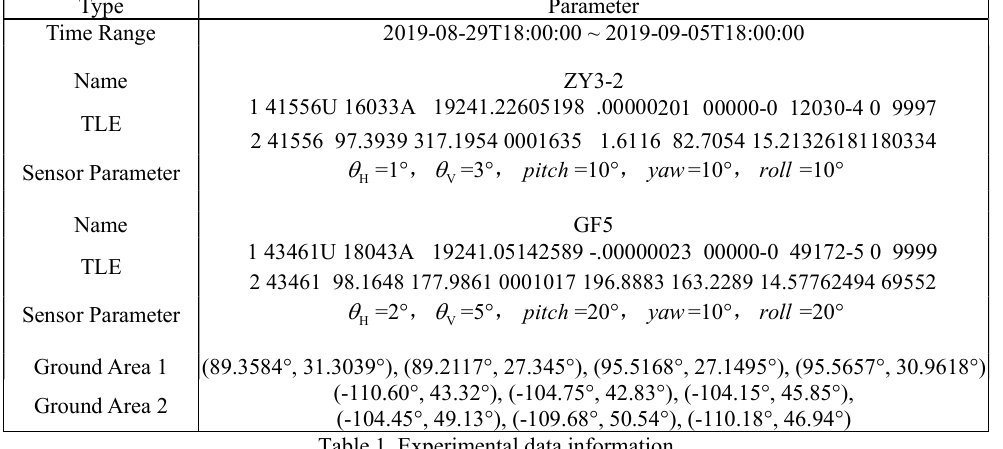
Table 1. Experimental data